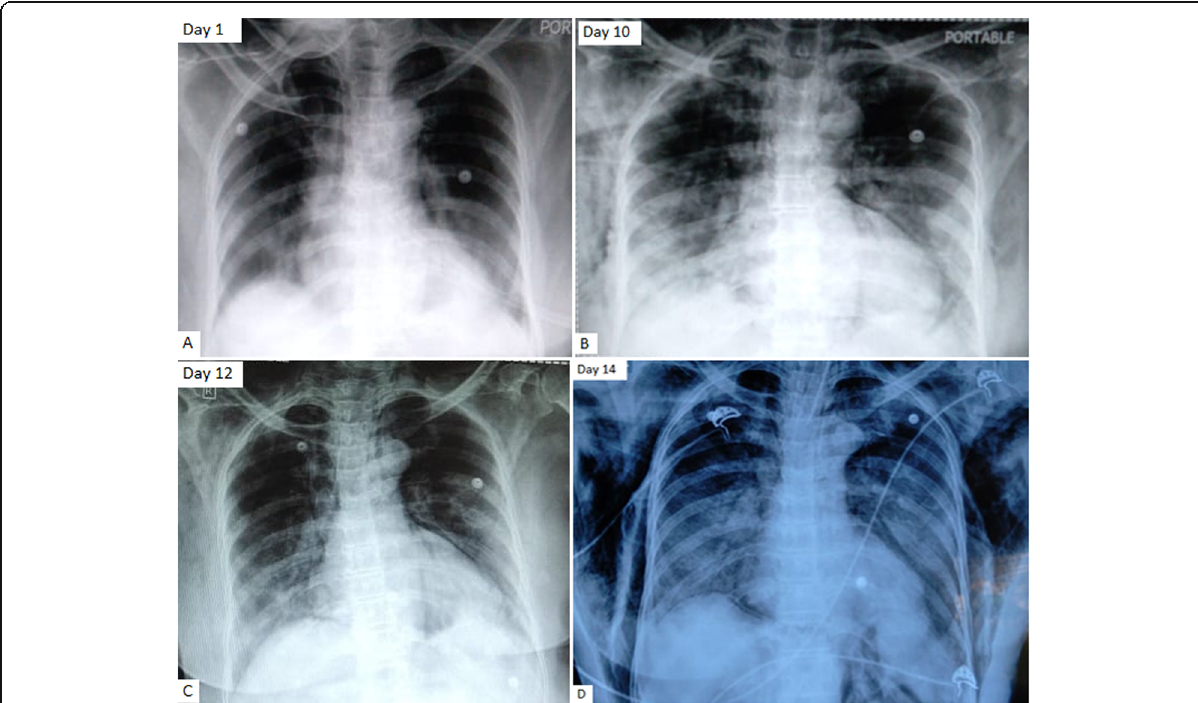
Fig. 1 A Day 1 chest X-ray antero-posterior view showing bilateral pneumonia. B Day 10 chest X-ray showing subcutaneous emphysema and pneumopericardium. C Day 12 chest X-ray partial resolution of subcutaneous emphysema. D Day 14 chest X-ray showing recurrence of subcutaneous emphysema with an increase in lung